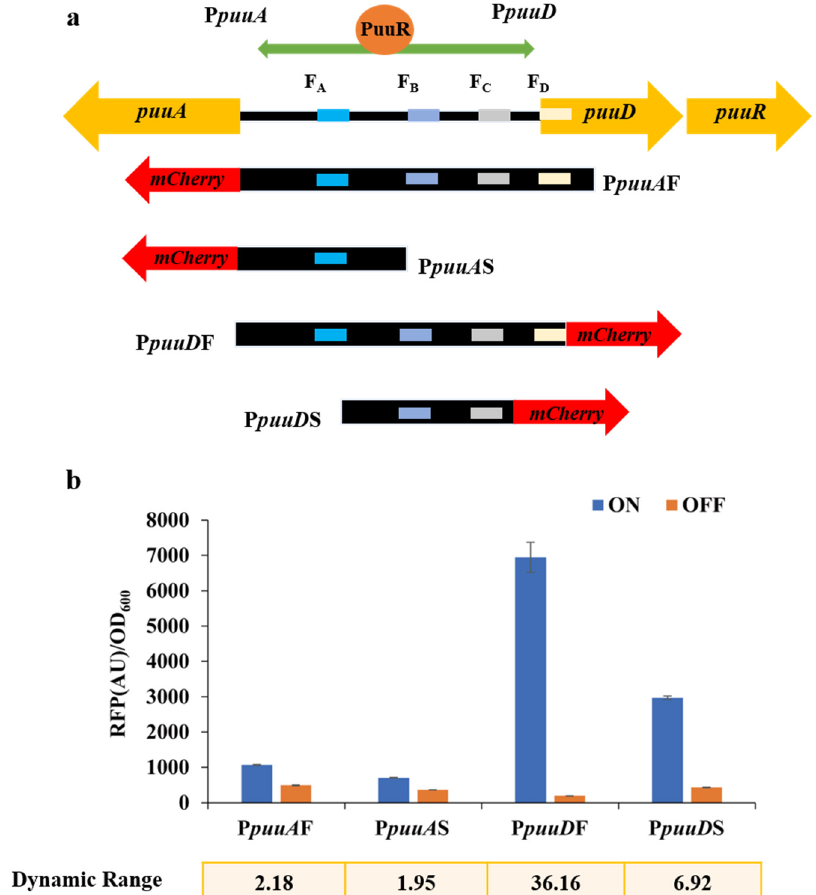
Figure 1 . Design of the putrescine biosensor and evaluation of the response promoter. ( a ) Mechanistic model of PuuR regulating puu gene expression and selection of the response promoter; ( b ) response promoter evaluation. 0.1 mM IPTG was added to induce the expression of PuuR. Cell fluorescence was normalized by cell density. Data are shown as the mean and standard deviation of independent triplicate.